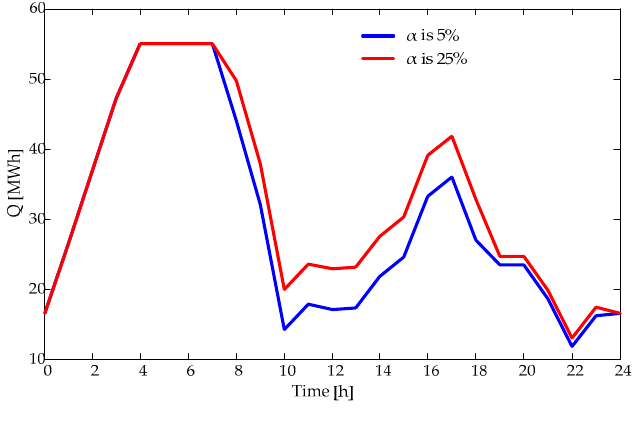
Figure 6. The remaining energy of the BSS.